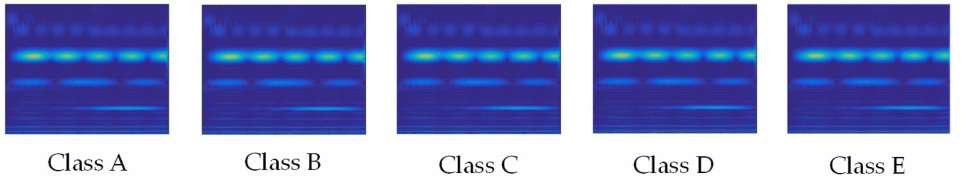
Figure 7. Acceleration sample images of five randomly selected vehicle